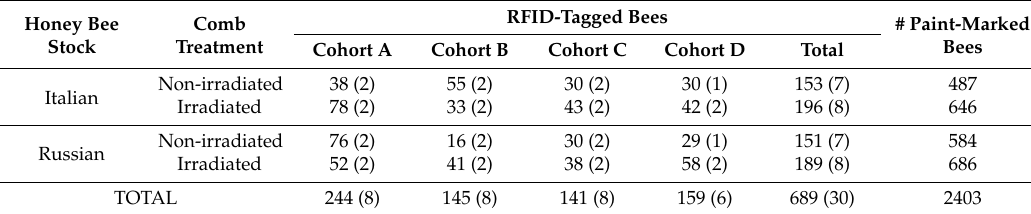
Table 1. Final number of Radio Frequency Identification (RFID)-tagged and paint-marked bees for all treatment groups. Numbers inside ( ) are the number of colonies